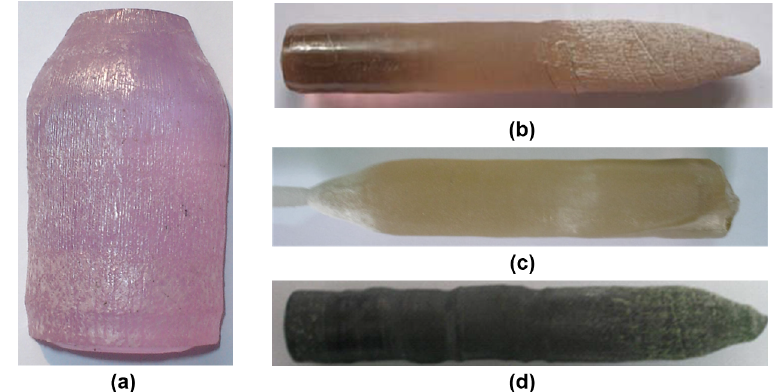
Figure 1. Photographs of as-grown Nd 3+ - and Er 3+ -doped GYSGG crystals: ( a ) Nd:GYSGG [5]; ( b ) Er:GYSGG [8]; ( c ) Er,Pr:GYSGG [9]; ( d ) Cr,Er,Pr:GYSGG [10].